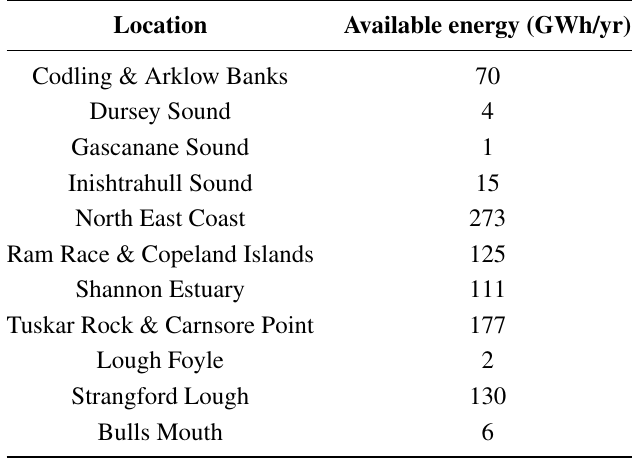
Table 2. Viable energy at the different locations. Data from